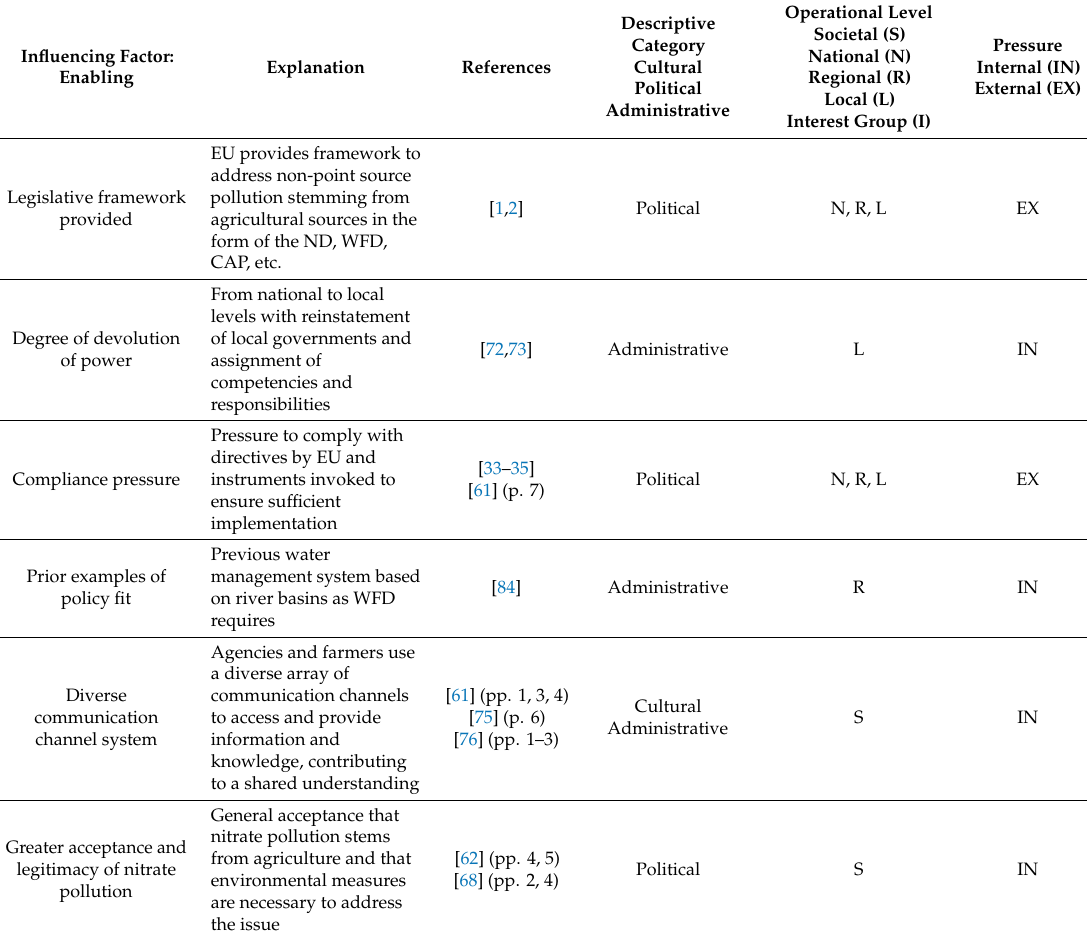
Table 3. Enabling